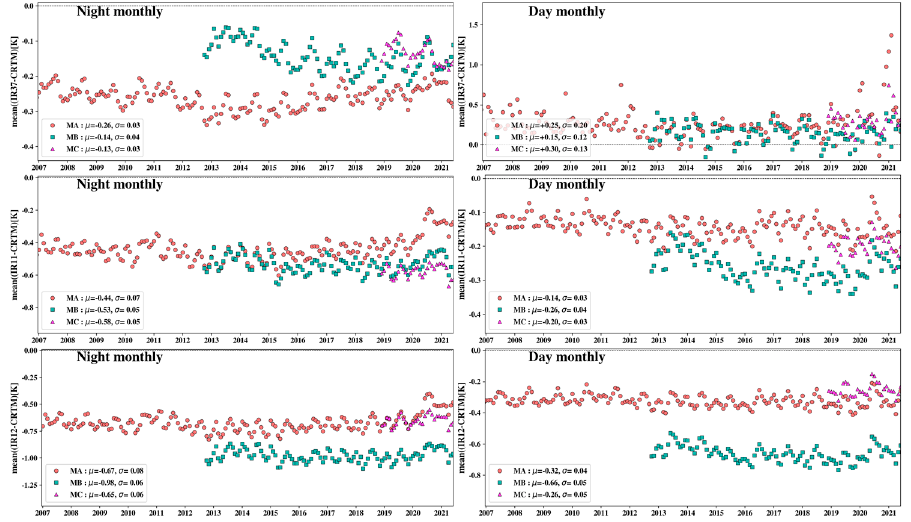
Figure 4. Monthly aggregated Observation—Model (O-M) biases in AVHRR thermal bands (top) 3.7 µm; (middle) 11 µm; (bottom) 12 µm of three Metop-FG satellites: (left) night; (right) day. Data are from the NOAA MICROS system [34,40] .